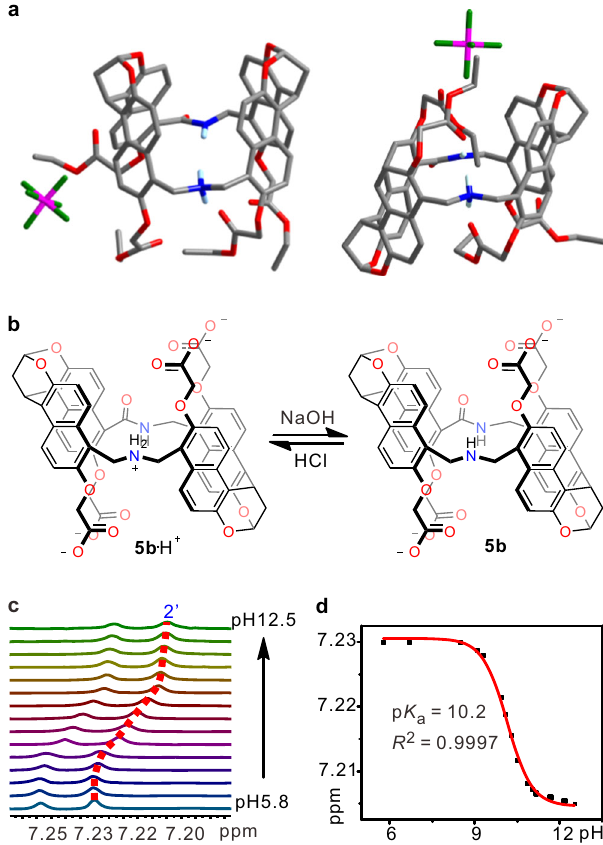
7.25 7.23 7.22 7.20 ppm Fig. 3 X-ray single crystal structures of 4 and p K a value determination of 5b. a X-ray single crystal structures of 4a and 4b . Solvent molecules and most of the hydrogen atoms are omitted for viewing clarity. Color codes: carbon, gray; oxygen, red; nitrogen, blue. b Interconversion between the protonated and deprotonated states of 5b . c Partial 1 H NMR spectra of 5b upon changing the pH values. d Titration curve tracking the change in the chemical shift of 5b with changing the pH values, which was fi t to the Henderson-Hasselbalch equation to determine p K a value and Hill coef fi